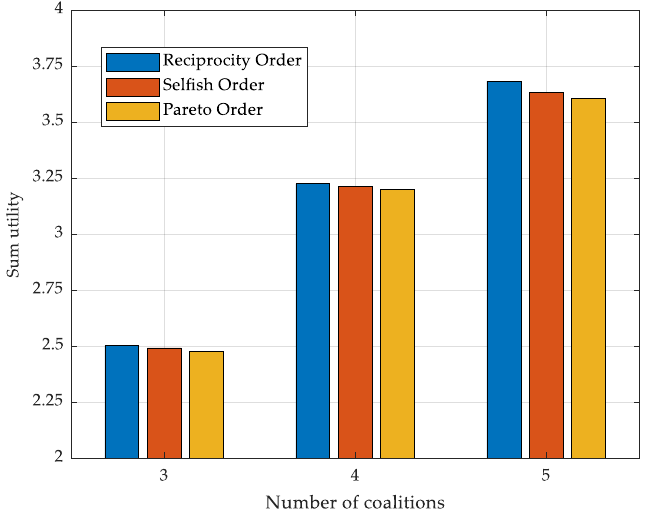
Figure 7. Schematic representation of the impact of the number of coalitions on the performance of the proposed algorithm.